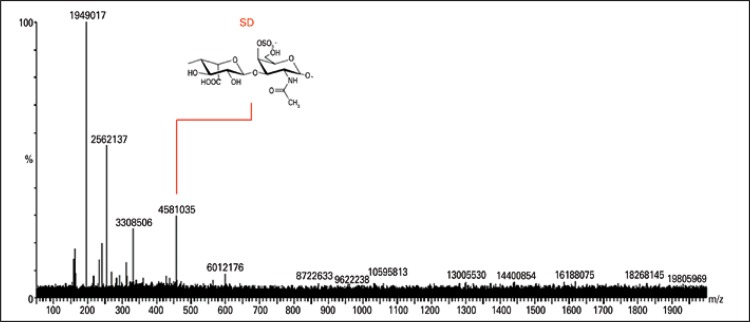
Espectroscopia de massa para identificar oligossacarídeos de sulfato de dermatan. Os oligossacarídeos e dissacarídeos de sulfato de dermatan foram obtidos após digestão com condroitinase B. Os produtos foram comparados com o padrão de produtos de sulfato de dermatan